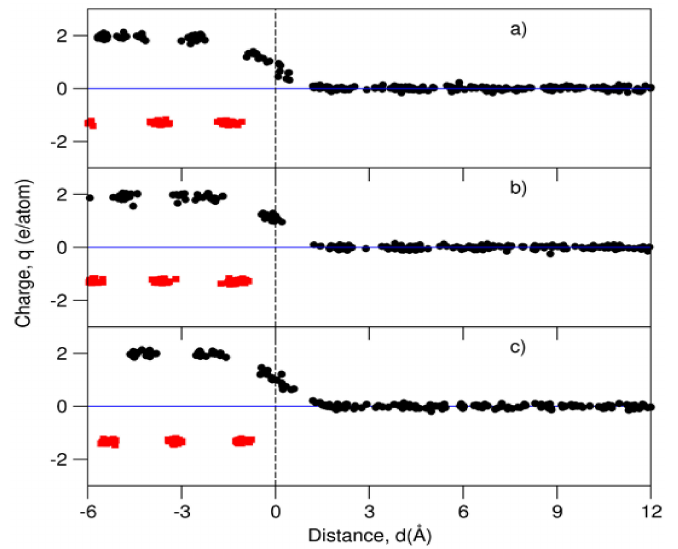
Figure 6. There is charge transfer occurring from the terminating Al atoms to the outmost O ions. Charges at the atomic sites across the Al( l )/ γ -Al 2 O 3 {1 1 1} Al_1 ( a ), Al( l )/ γ -Al 2 O 3 {1 1 1} Al_2 ( b ) and Al( l )/ α -Al 2 O 3 {0 0 0 1} ( c ) interfaces [49,62]. The red squares represent charges at O, black at Al.